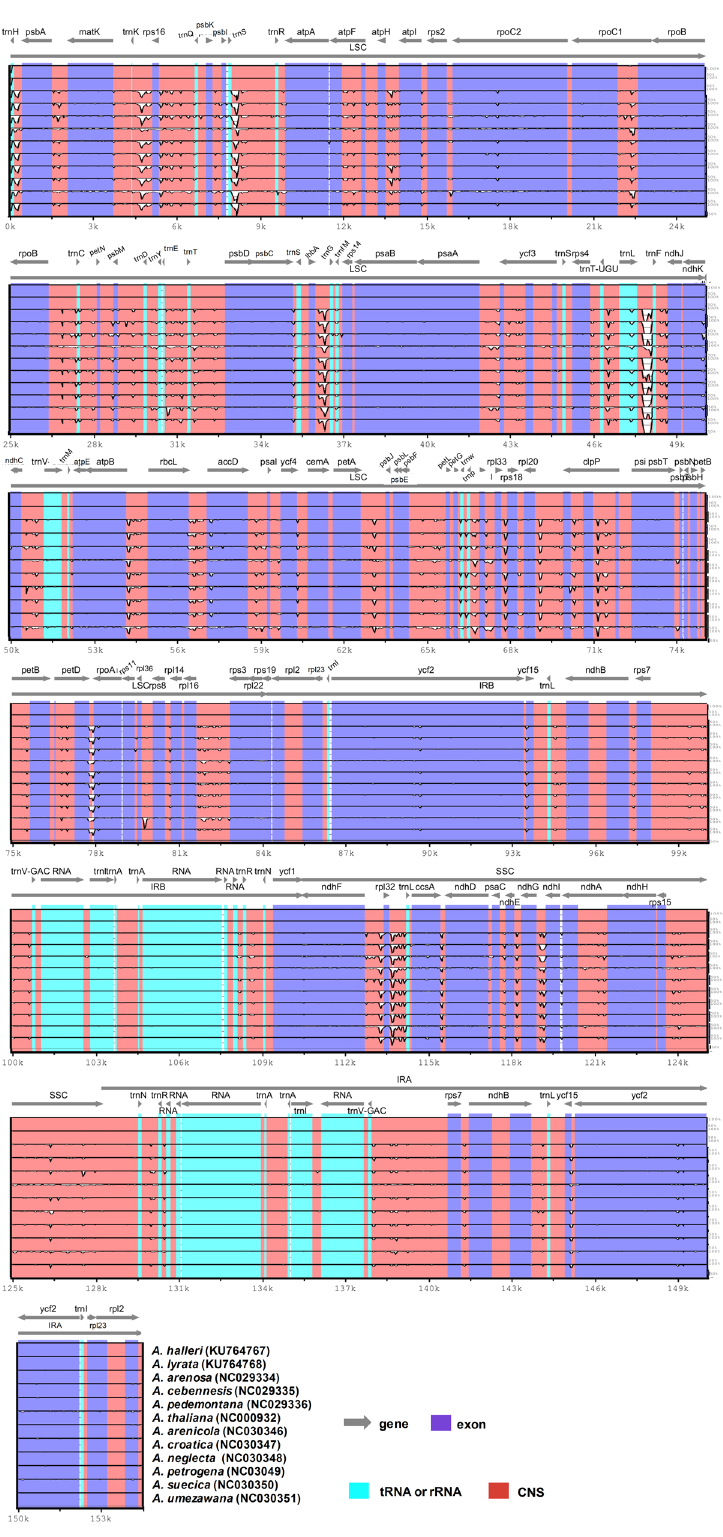
Figure 5. Alignment visualization of the twelve Arabidopsis chloroplast genome sequences. VISTA-based identity plot showing sequence identity among the six-species using A . halleri ssp. gemmifera as a reference. Vertical scale indicates the percentage of identity, ranging from 50% to 100%. Horizontal axis indicates the coordinates within the chloroplast genome. Arrows indicate the annotated genes and their transcriptional direction. The thick black lines show the inverted repeats (IRs) in the chloroplast